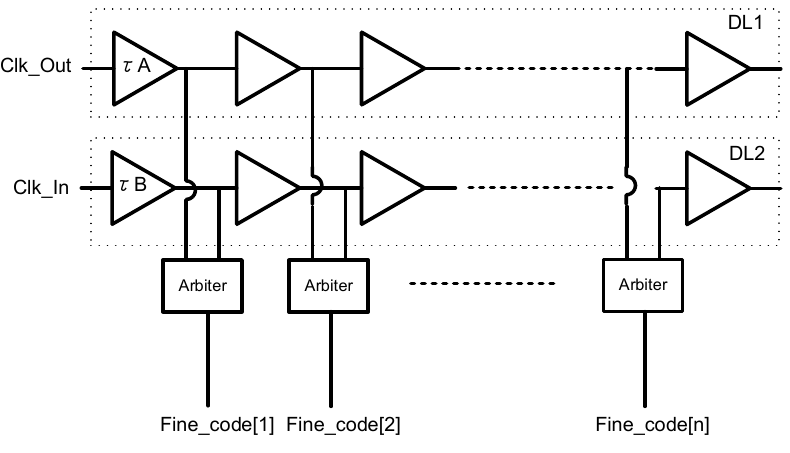
Figure 5. Fine detector.